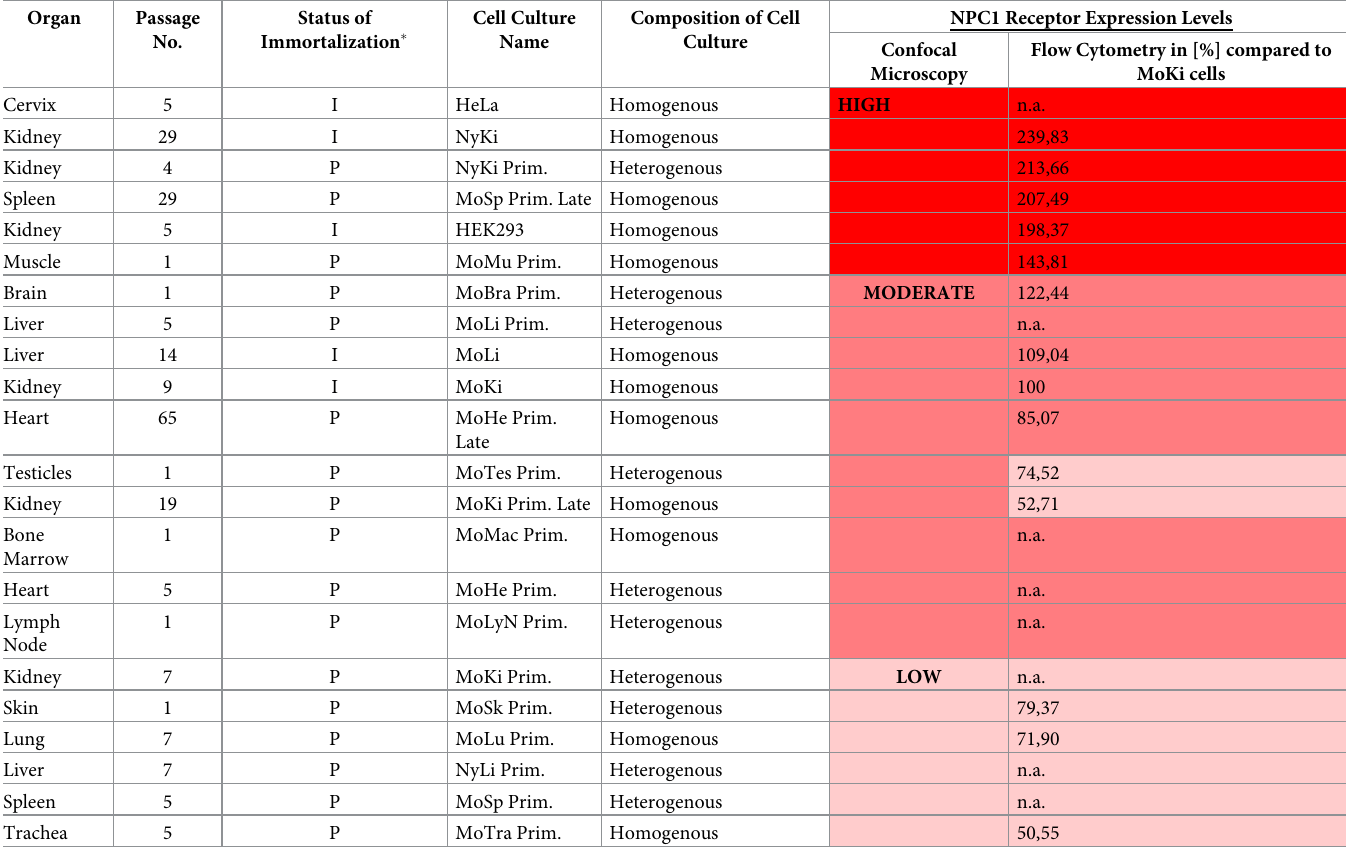
Table 2. Cells tested for their NPC1 receptor expression levels with confocal microscopy and flow cytometry. Organ Passage